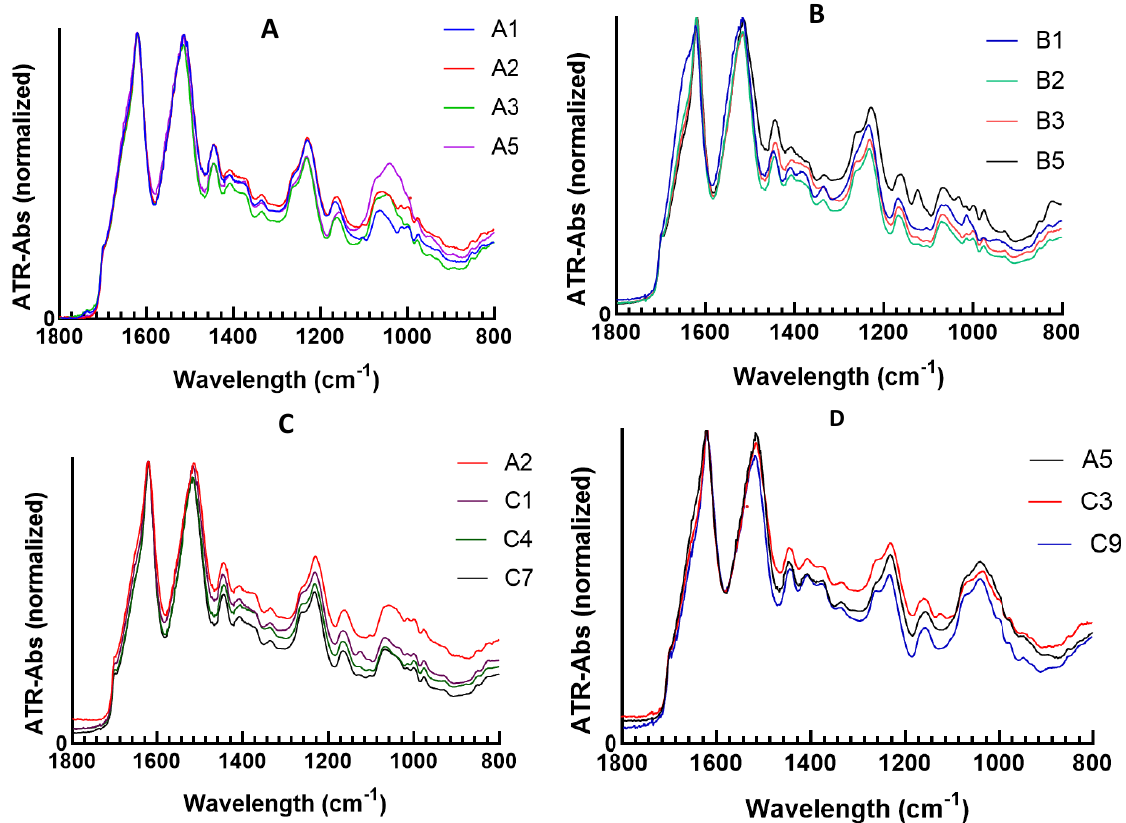
Figure 5. ATR − FTIR absorbance spectra of ( A ) SF/HA hydrogels (A1, A2, A3, A5), ( B ) SF/curcumin hydrogels (B1, B2, B3, B5); ( C ) SF/HA/curcumin hydrogels with SF/HA = 80/20 and SF/curcumin 0, 2/1, 4/1 and 8/1 (A2, C1, C4, C7) and ( D ) SF/HA/curcumin hydrogels with SF/HA = 40/60 and SF/curcumin 0, 2/1, and 8/1 (A5, C3, C9).